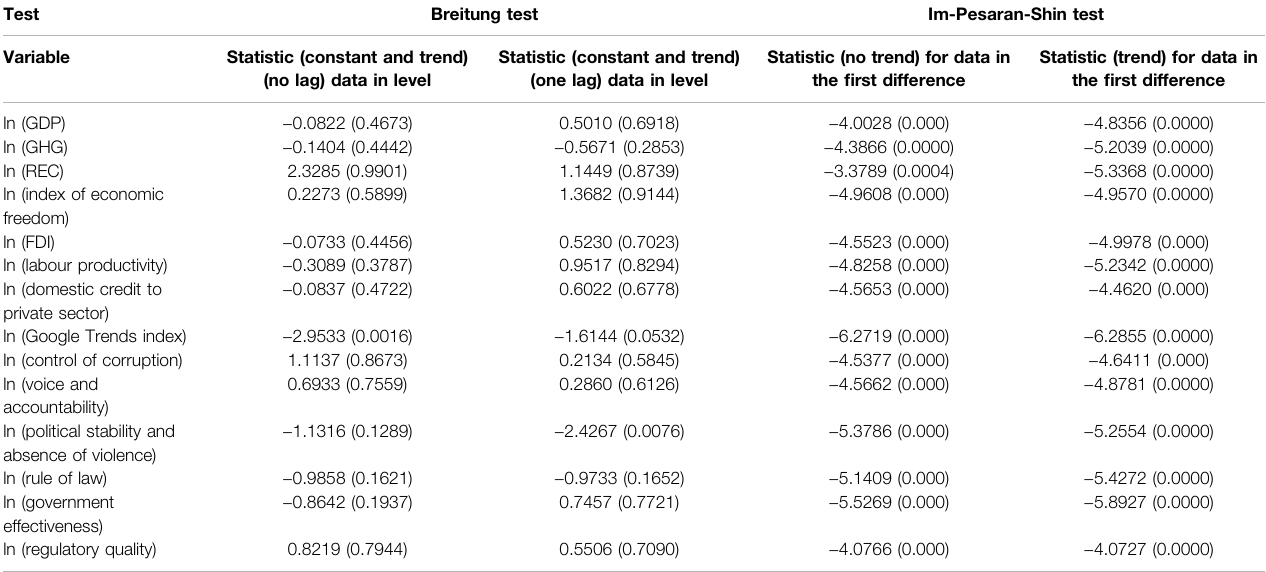
TABLE 3 | The results of Breitung and Im-Pesaran-Shin tests for unit root ( p -values in brackets). Test Breitung test Statistic (constant and trend) Statistic (constant and trend) Statistic (no trend) for data in Statistic (trend) for data in (no lag) data in level (one lag) data in level the fi rst difference the fi rst